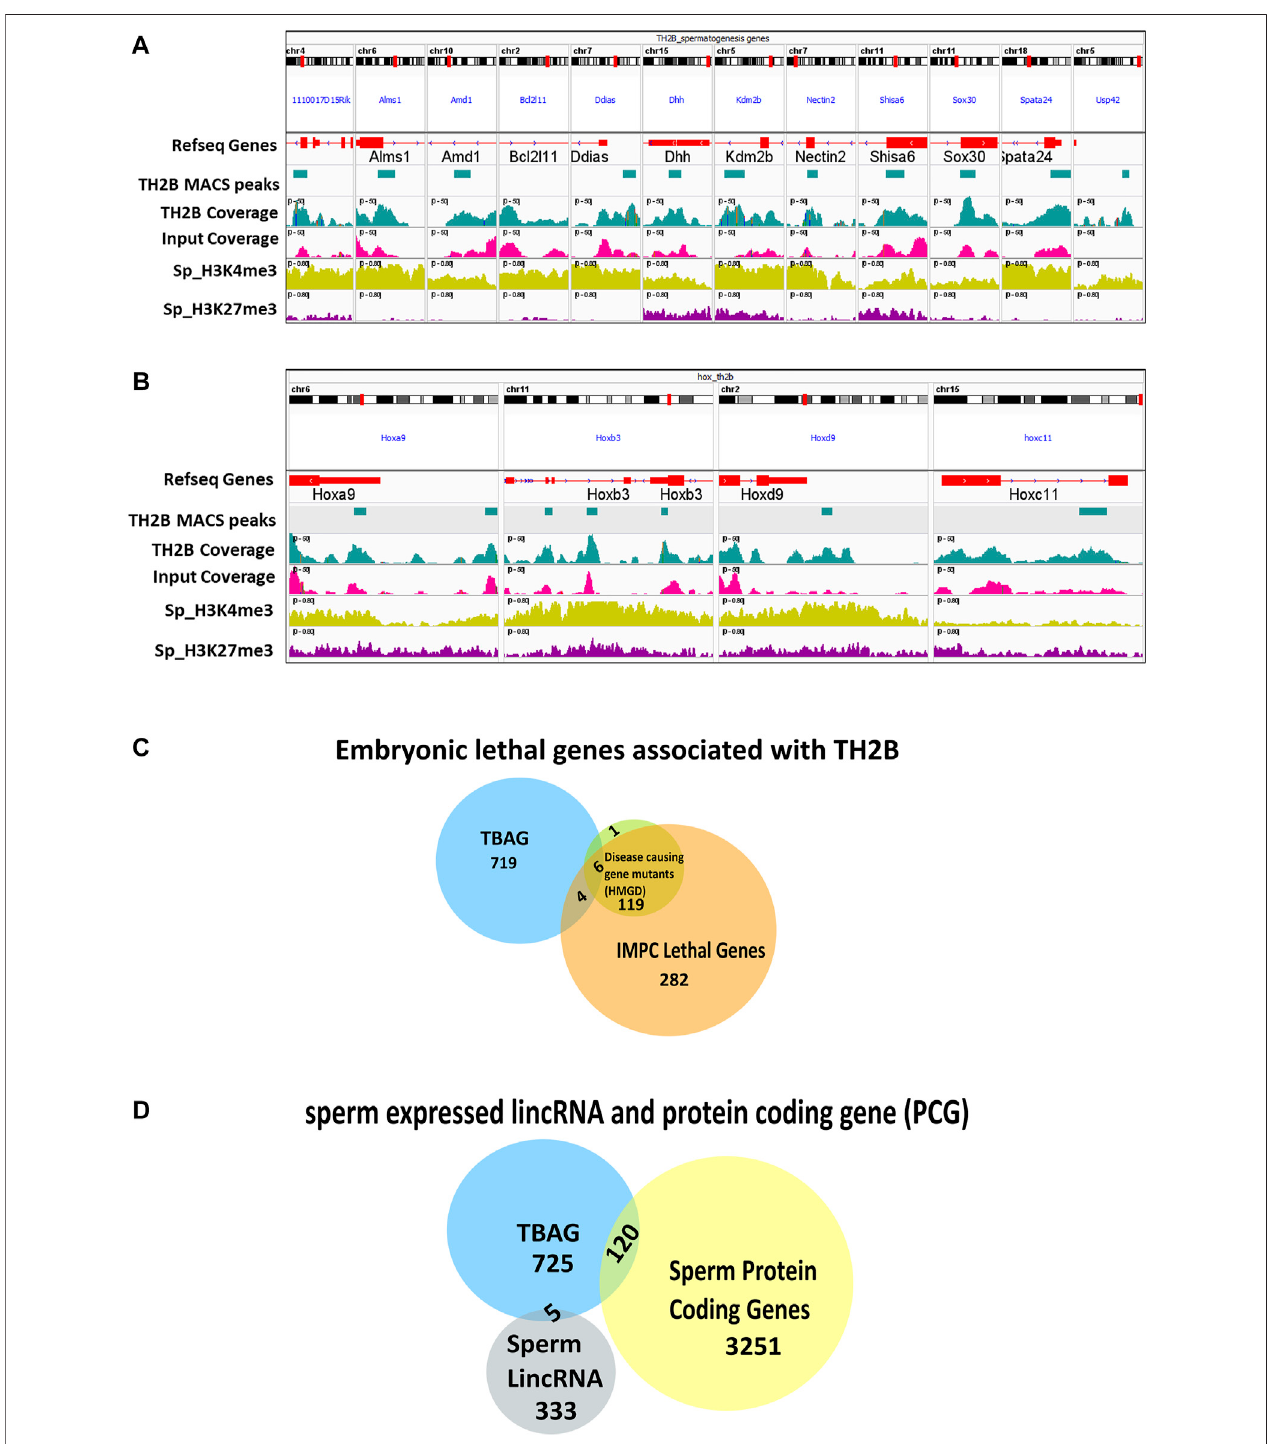
FIGURE 6 | (A, B) IGV view showing TH2B MACS2 peak at genes important for spermatogenesis and at HOX cluster genes, respectively, along with ChIP Atlas bigWigcoveragealignmenttracksforspermPTMsH3K4me3(activatingmark)andH3K27me3(repressivemark). (C) Venndiagramshowingthecommonembryonically lethal genes between TH2B-associated gene (TBAG) list and gene lists extracted from the International Mouse Phenotyping Consortium (IMPC) and Human Genome Mutation Database (HGMD). (D) Venn diagram showcasing the TBAGs common to sperm-derived protein coding gene (PCG) list and lincRNA list.